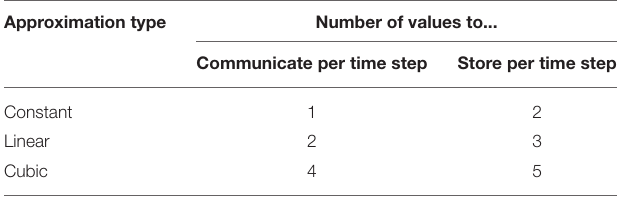
TABLE 2 | Storage and communication demand for different approximation types. Approximation type Number of values to...